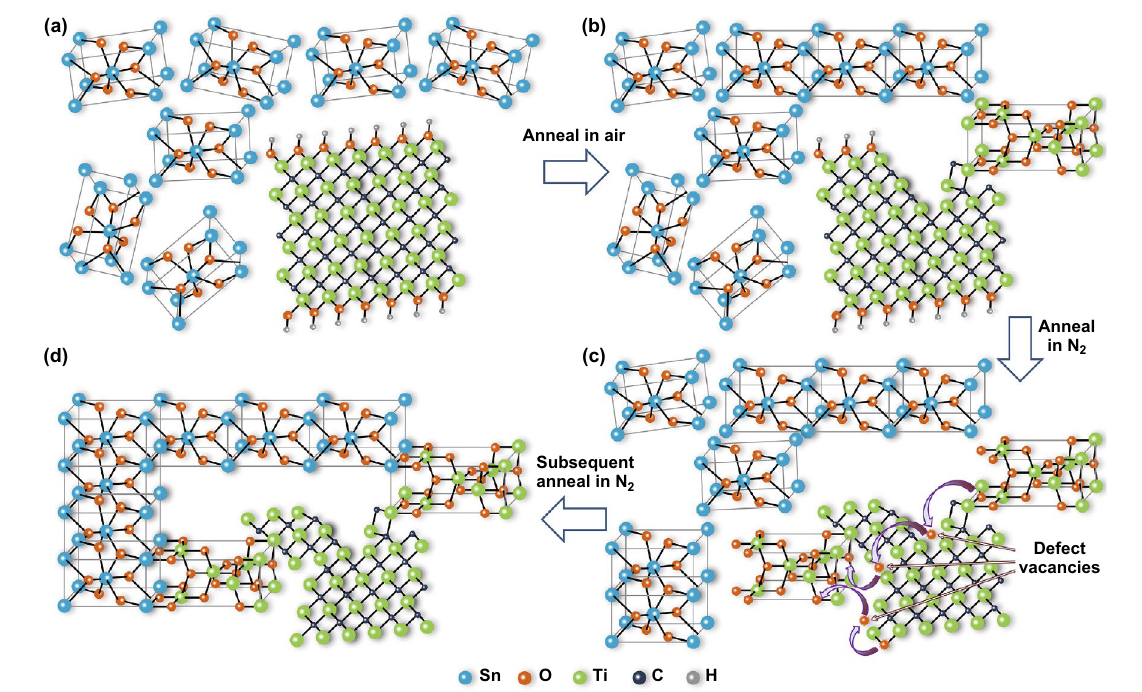
Fig. 5 a – d Generation mechanism of MDCN